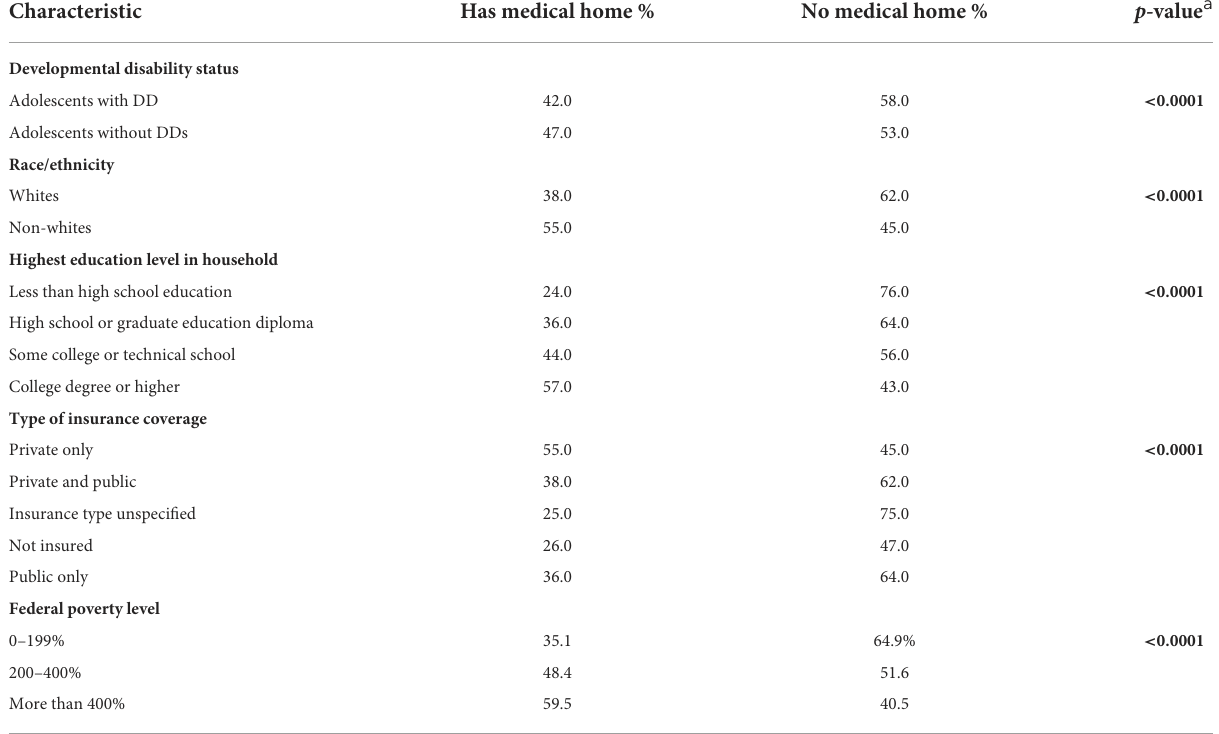
TABLE 4 Characteristics of adolescent disability status, demographic variables, and reported patient centered medical home. Characteristic Has medical home